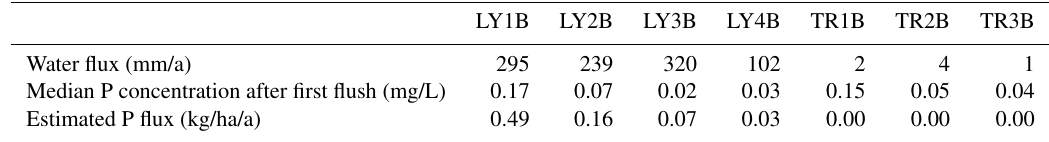
Table 7. Estimation of annual P tot fluxes in vertical (LY) and lateral (TR) SSF at CON calculated based on the mean P concentration after the first flush during the sprinkling experiment at CON in summer (see Fig. 5) and the water flux between 10 May 2018 and 10 May 2019. This period was chosen in order to not include the sprinkling experiments. No long-term measurements are available for MIT and